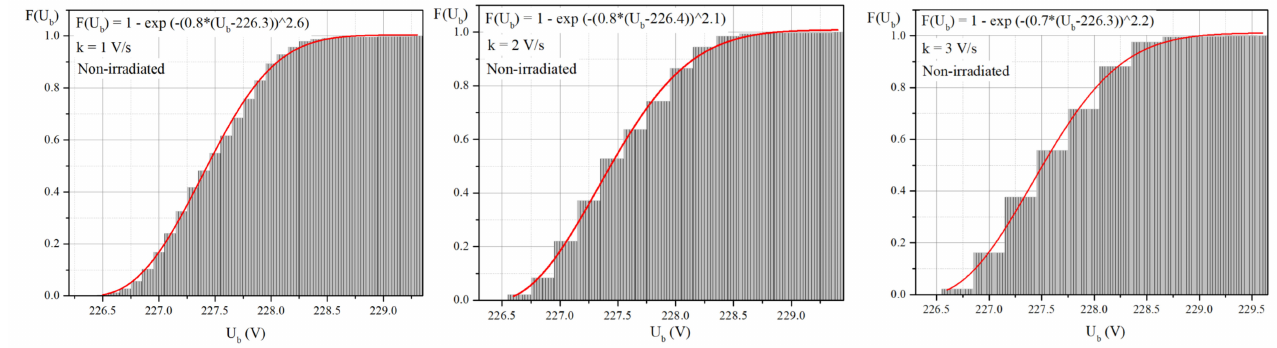
Figure 8. Cumulative distribution functions of non-irradiated CITEL GFSA for increase voltage rates k = 1 V/s, k = 2 V/s, and k = 3 V/s, respectively.